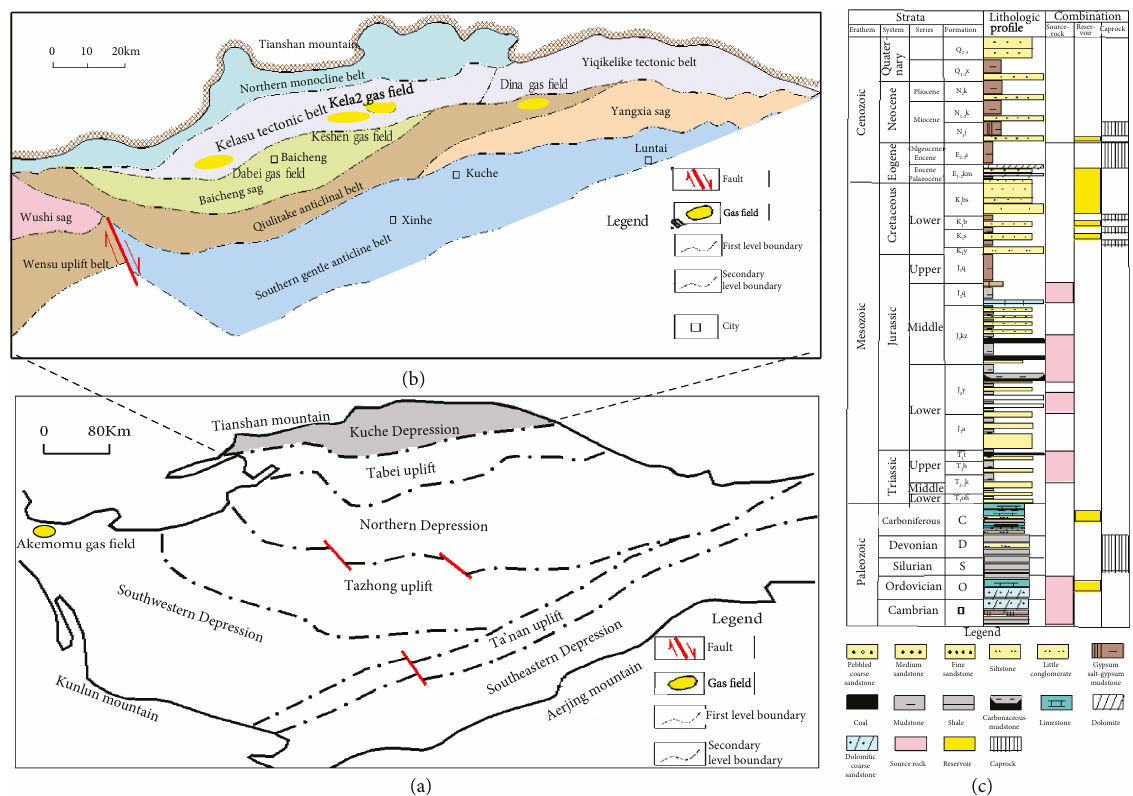
Figure 1: Gas fi eld distribution and structural unit divisions of the Kuche and Southwestern Depressions, Tarim Basin (modi fi ed from